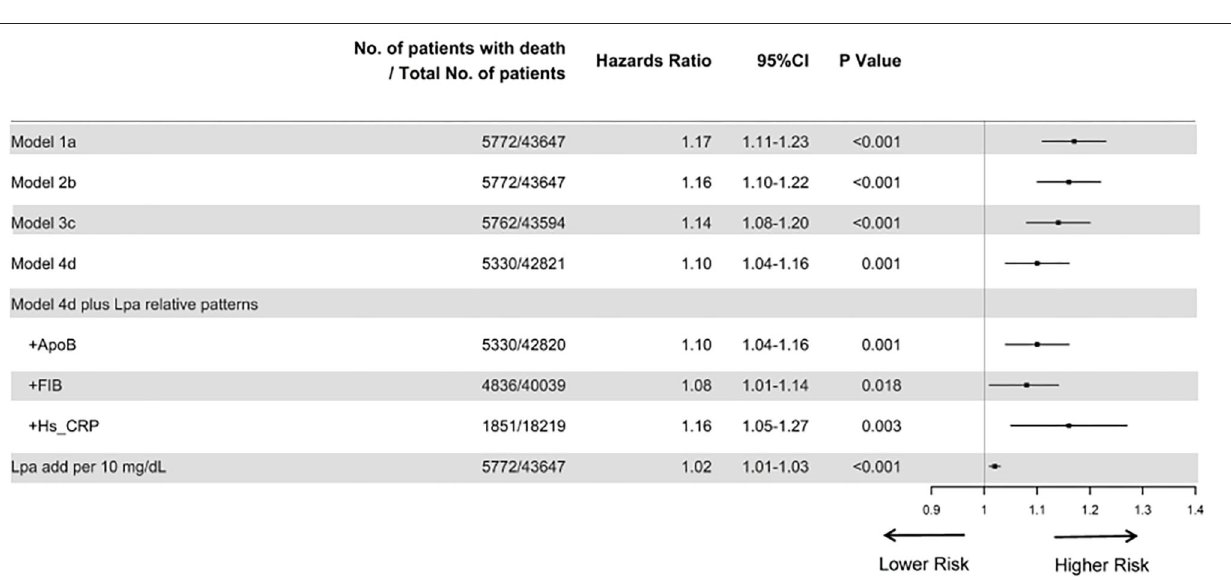
FIGURE 2 | Restricted spline curve for the lipoprotein(a) hazard ratio. This reflects spline of degree 3 (piecewise cubic curve) with natural cubic basis and 3 knots. (A) The restrict spline curve of a univariate Cox model. (B) The restrict spline curve of a multivariate Cox model, adjusted for age, gender, hypertension, acute myocardial infraction, diabetes mellitus, percutaneous coronary intervention, hemoglobin, white blood cell, congestive heart failure, total cholesterol, triglyceride, apolipoprotein A, low-density lipoprotein cholesterol, high-density lipoprotein cholesterol, chronic kidney disease, angiotensin-converting enzyme inhibitor/angiotensin receptor blockers, β -blockers, and statins.